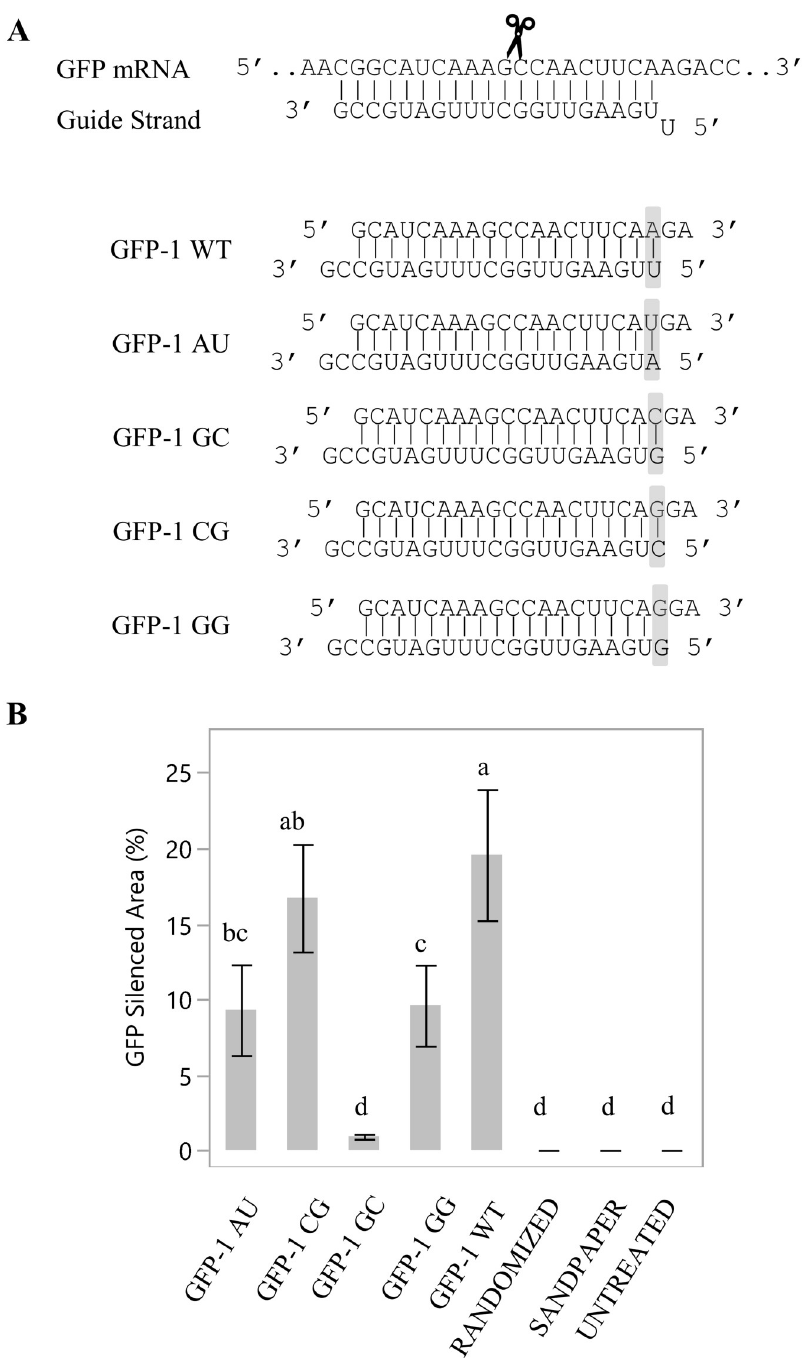
Fig 2. The influence of the 5’ nucleotide of the antisense strand of a 21nt siRNA duplex on GFP transgene silencing. A, Illustration of interactions between the GFP mRNA and the AS strand of siRNA duplex. dsRNAs with different 5’ nucleotides for the antisense strand (paired with a complementary or identical (G) nucleotide at the sense strand) were tested. B, GFP silenced area was quantified and expressed as percent of the treated leaf area; error bars are standard error of the means. Means not followed by the same letter indicate statistical significance ( α = 0.05).